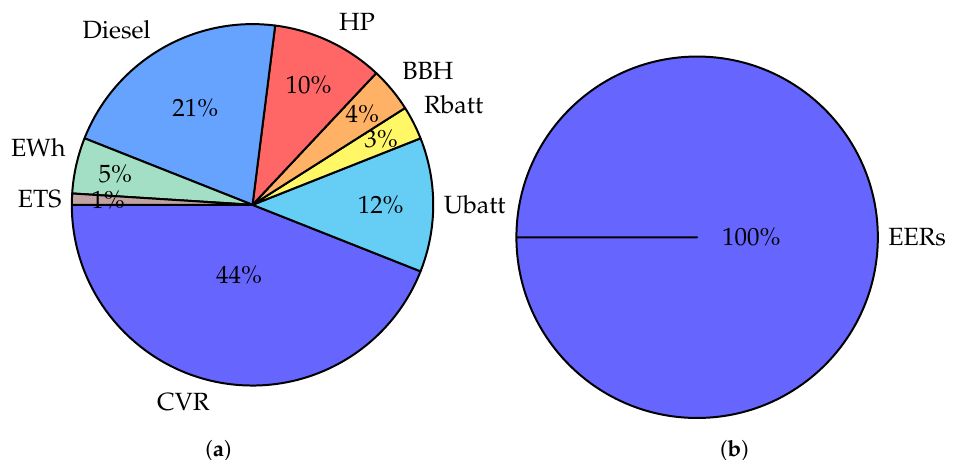
Figure 6. ( a ) Contributions of EERs; ( b ) total contributions of EERs and main generation.